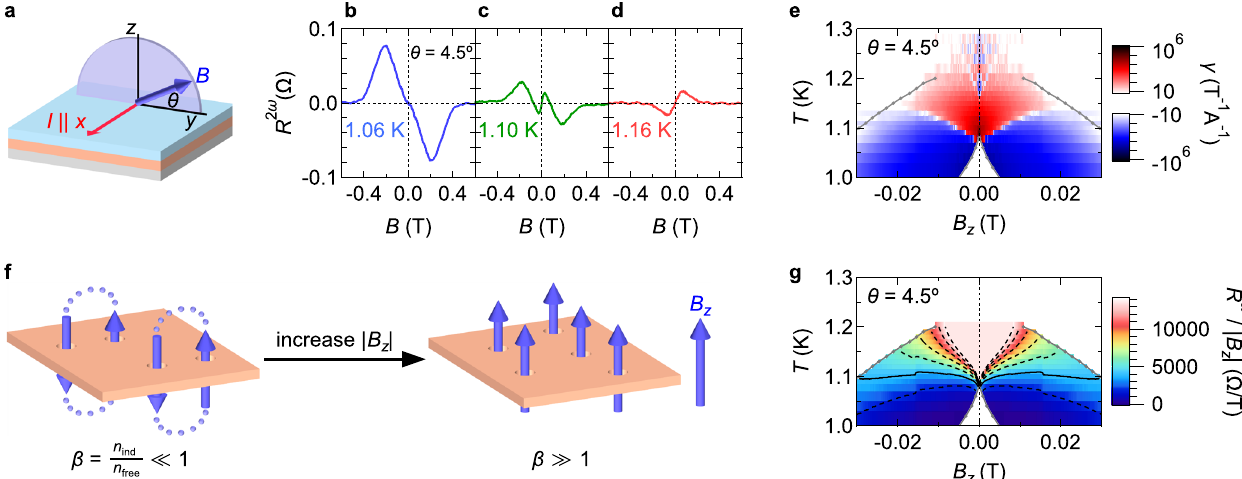
Fig. 3 Impact of out-of-plane magnetic fi eld on the nonreciprocal transport. a Schematic of the measurement con fi guration. θ is de fi ned as the tilting angle of magnetic fi eld B from the in-plane y- axis. b – d Magnetic fi eld dependence of R 2 ω at 1.06, 1.10, and 1.16 K for θ = 4.5°. e Color plot of γ in the B z − T plane at θ = 4.5° ( B z = B sin θ ). f Schematics of the free-vortices dominant state (left, β (cid:5) 1 ) and induced-vortices dominant one (right, β (cid:6) 1 ) with β (cid:7) n ind = n free . As | B z | increases, the crossover from the free-vortices dominant state to the induced-vortices dominant one is expected to occur. g Color plot of R ω / | B z | in the B z − T plane at θ = 4 . 5°. Contour lines for R ω / | B z | = 2000, 4000, … 14000 Ω T − 1 are plotted by black dotted lines. The solid line corresponds to R ω /|B z | = 4000 Ω T − 1